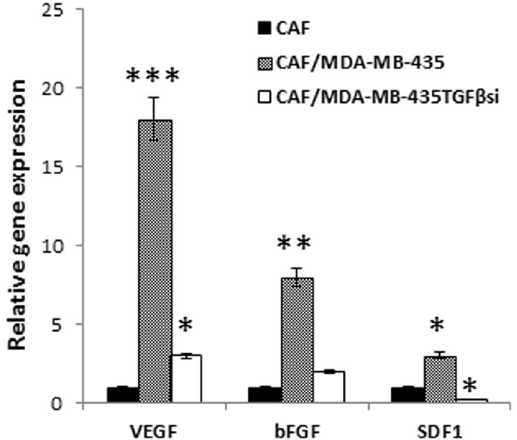
Figure 6. Analysis of growth factor expression in co-cultured fibroblasts. CAFs were cultured in Boyden chambers with either MDA-MB-435 cells or MDA-MB-435TGF β si cells for 72 hrs. RNA was collected from the cells and analyzed for VEGF, bFGF and SDF-1 expression. RT-PCR analysis was performed in triplicates and normalized to GAPDH values and expressed as relative gene expression to gene expression levels in control